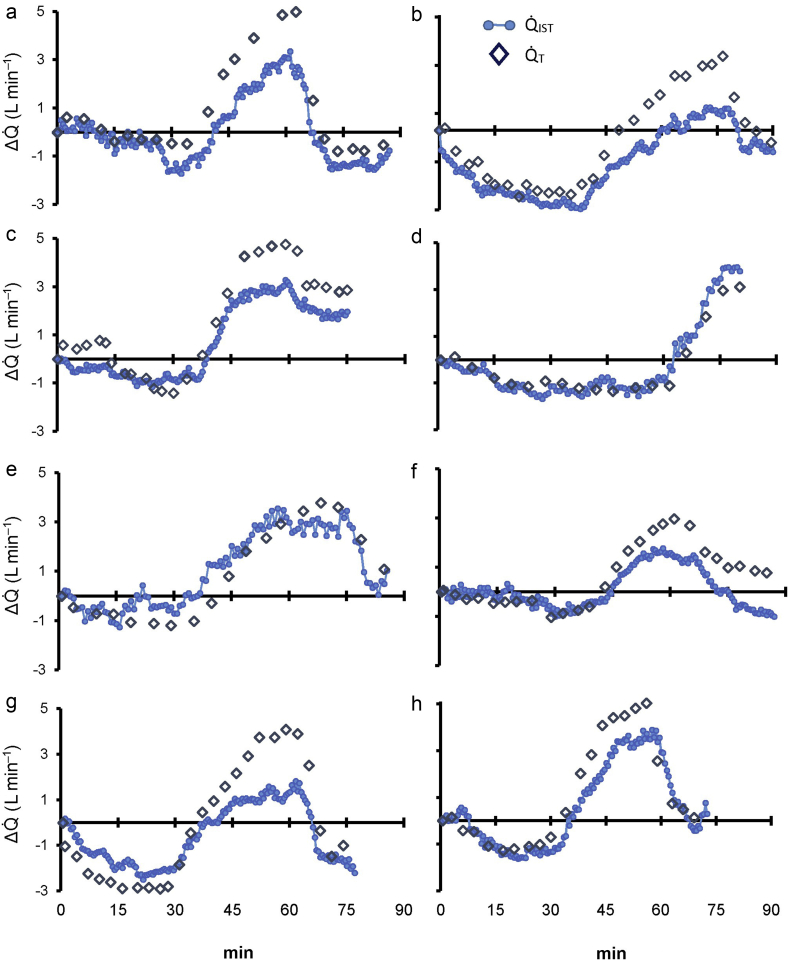
(a–h) ΔQ˙ from baseline in all eight animals throughout the protocol. Dark blue diamonds are Q˙T measurements, and light blue dots and lines are Q˙IST measurements.